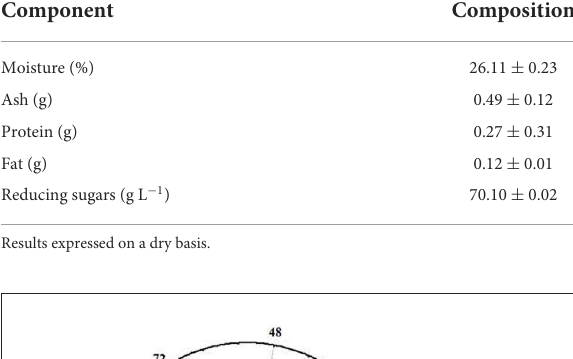
TABLE 1 Proximal composition of maltose syrup.